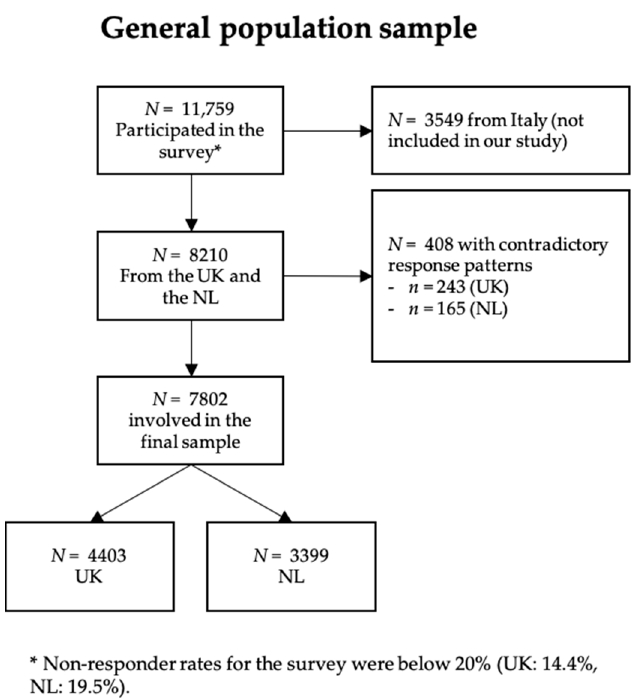
Figure 1. Sample attrition chart (general population).